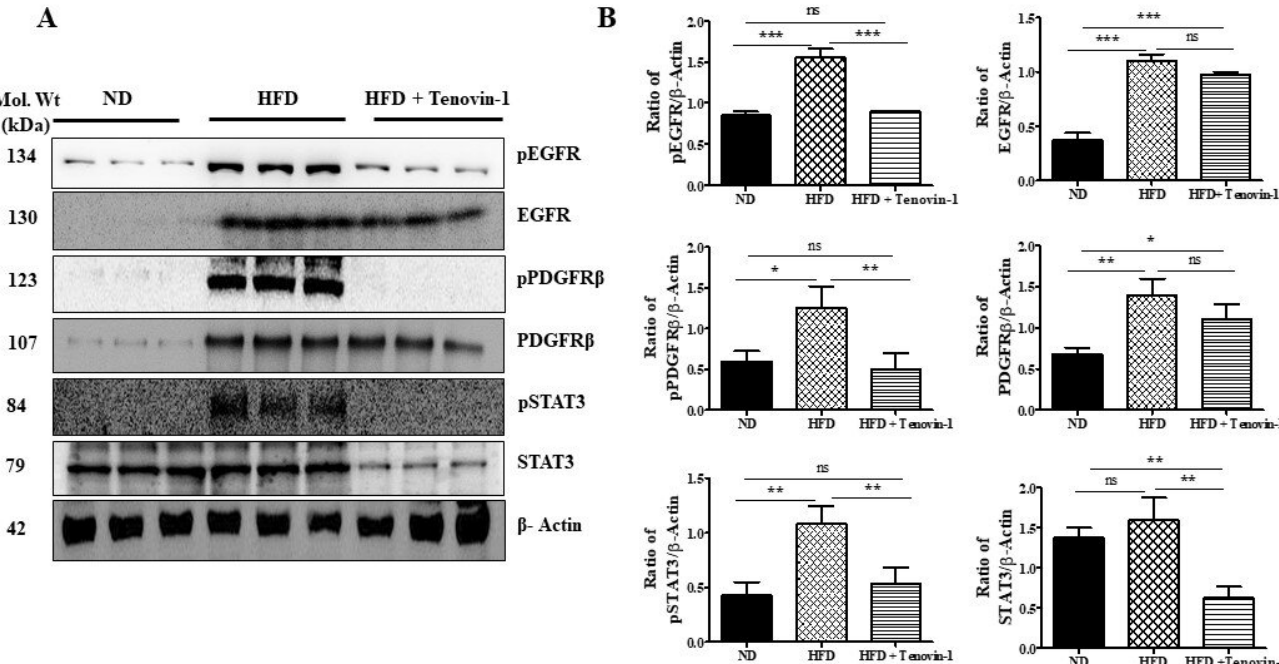
Figure 9. Effect of Tenovin ‐ 1 on EGFR, PDGFR β , and STAT3 phosphorylation in the kidney tissues of HFD ‐ fed diabetic rats. ( A ) The total and phosphorylated levels of EGFR, PDGFR β , and STAT3 were examined using Western blot analysis. β‐ actin was used as the loading control. Three separate Western blot experiments were used to obtain the results. ( B ) The intensities of the bands were analyzed densitometrically using Image J software. The data are the means ± SD of duplicate experiments (6 animals/group). Statistical analysis was performed using one ‐ way ANOVA followed by Tukey’s HSD post hoc test for multiple comparisons (*** p < 0.001, ** p < 0.01, and * p < 0.05). ND, normal diet; HFD, high ‐ fat diet.